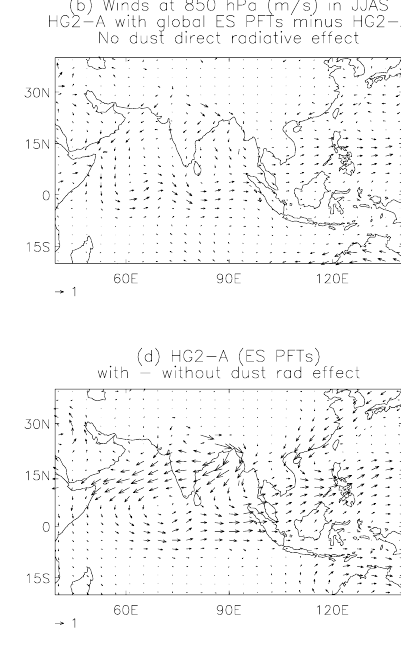
the impacts of the changes in the vegetation distribution by removing the direct radiative effects of